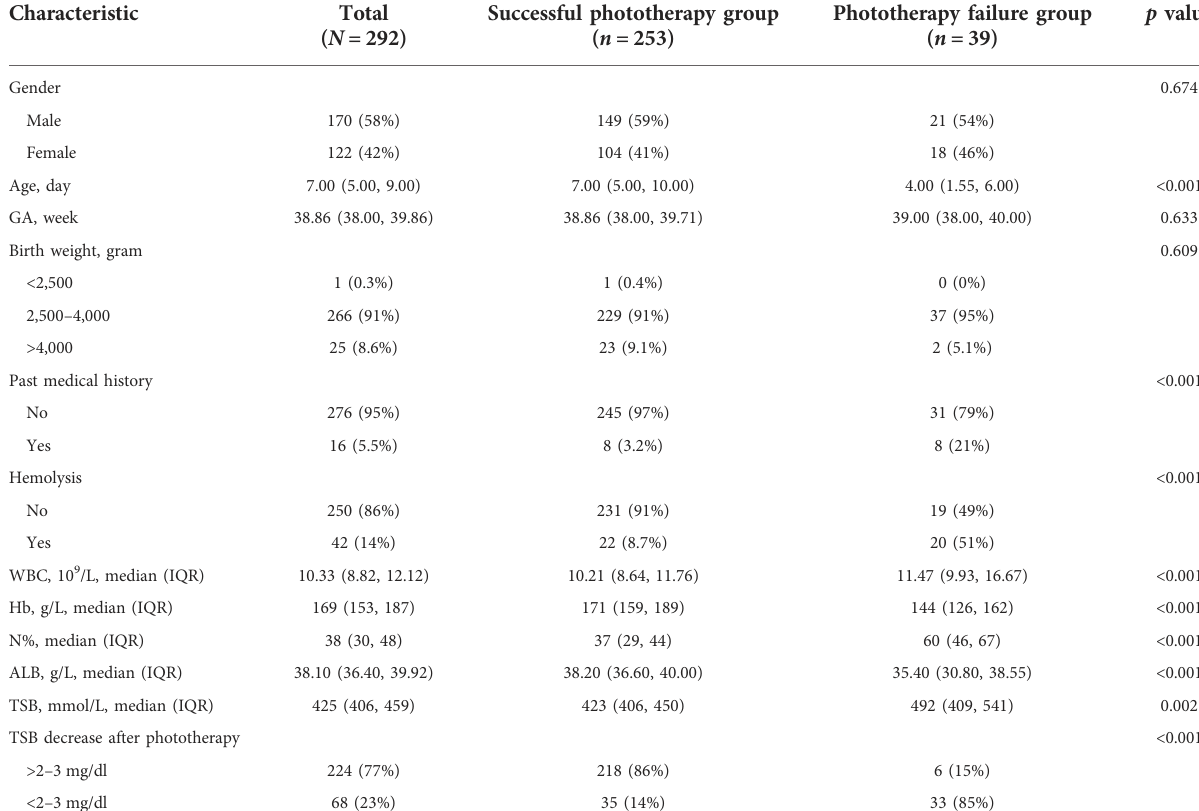
TABLE 1 Demographic and clinical characteristics of newborns in training cohort ( N =292).